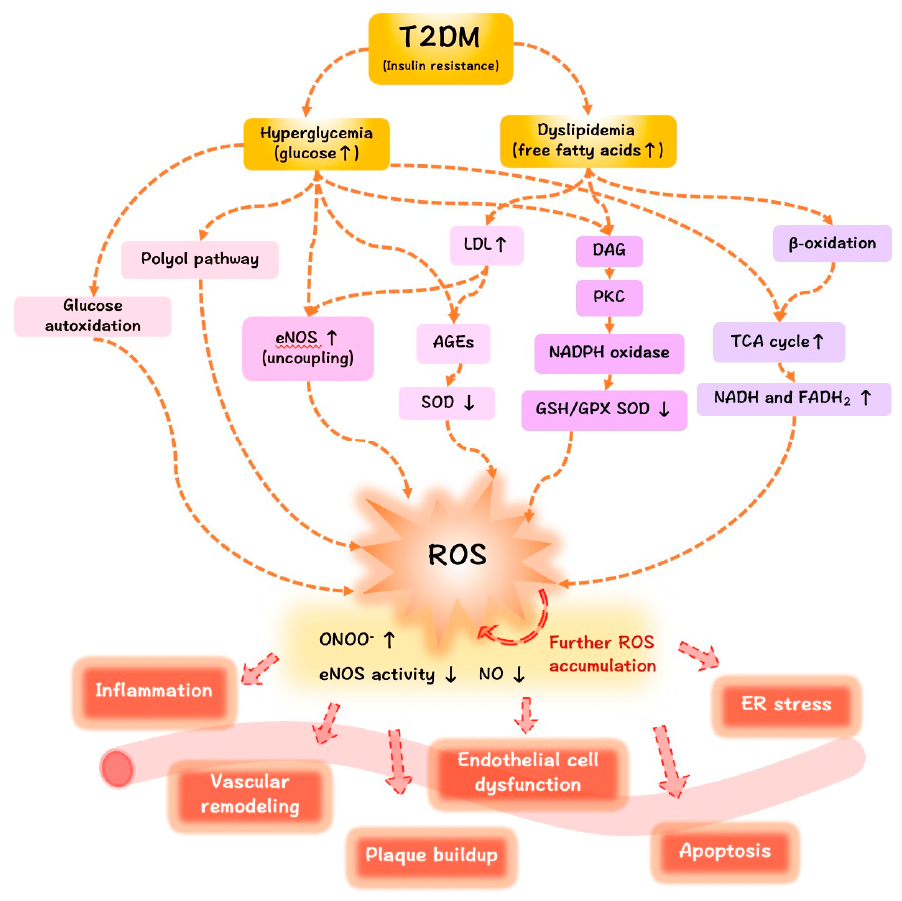
Figure 1. The mechanisms of ROS/oxidative stress generation in diabetes mellitus and the effects of ROS release on the vasculature. Table 1. Decrease of antioxidant enzymes as well as increase of ROS and RNS in rupture of redox homeostasis in diabetes mellitus.